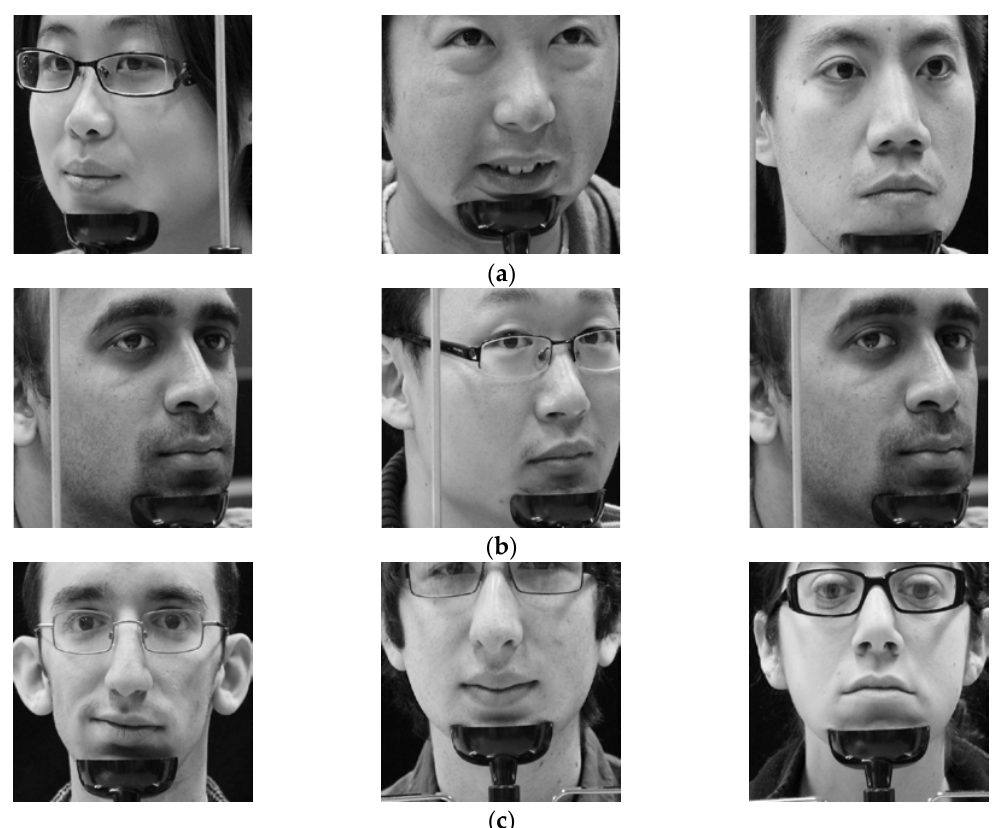
Figure 17. Incorrectly detected gaze zones with our system on CAVE-DB. Left, middle, and right figures respectively show the cases that user looks at gaze zones of ( a ) 1, 4, and 7; ( b ) 2, 5, and 8; ( c ) 3, 6, and 9, respectively, of Figure 15.